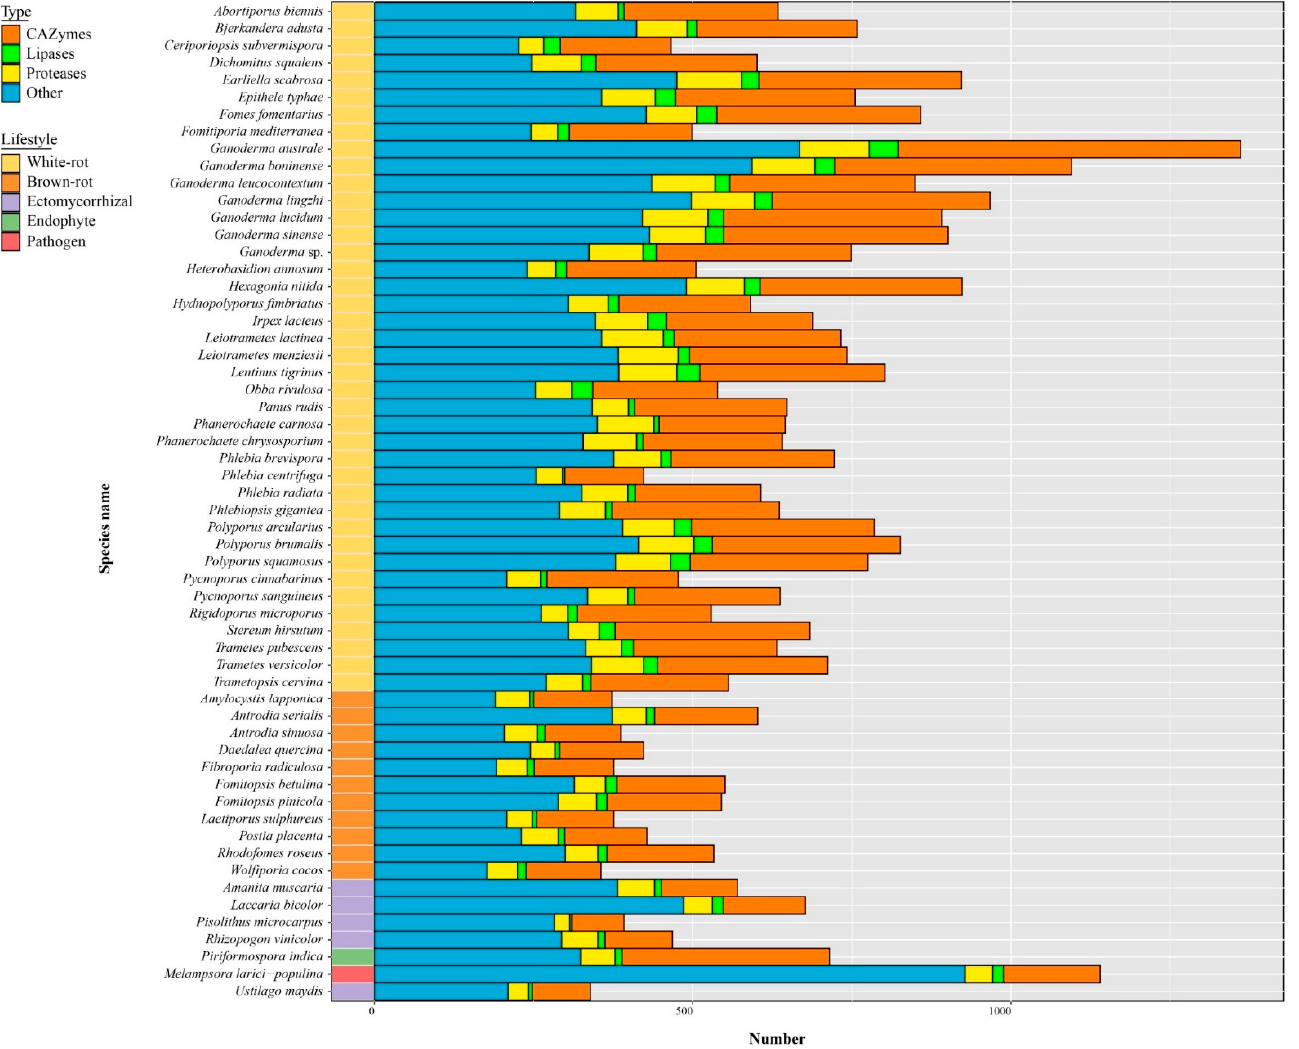
Figure 7. Distribution of predicted secreted proteins (i.e., secretome) in Ganoderma species and other selected fungi. Bars represent the gene copy number for CAZymes, lipases, proteases, and SSPs. Color codes for the five fungal lifestyles are shown at the top left of the figure.